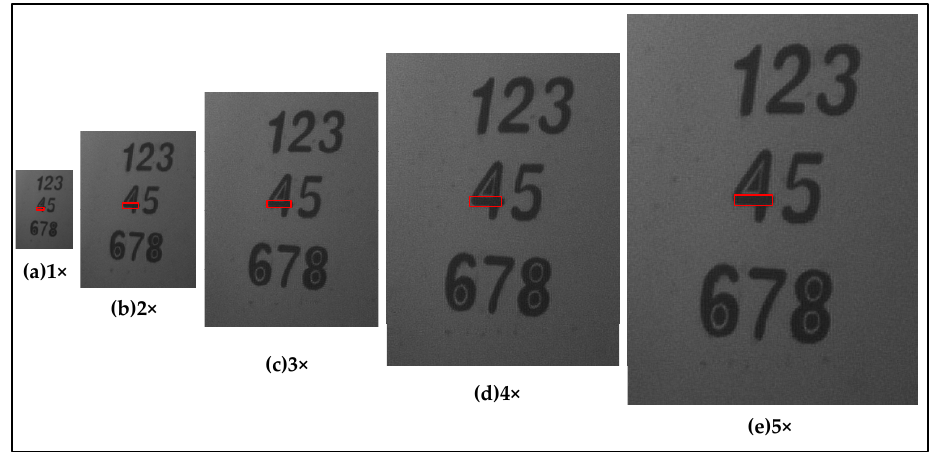
Figure 8. Images of target 3 at various magnifications. The inversion areas are highlighted by the red box.